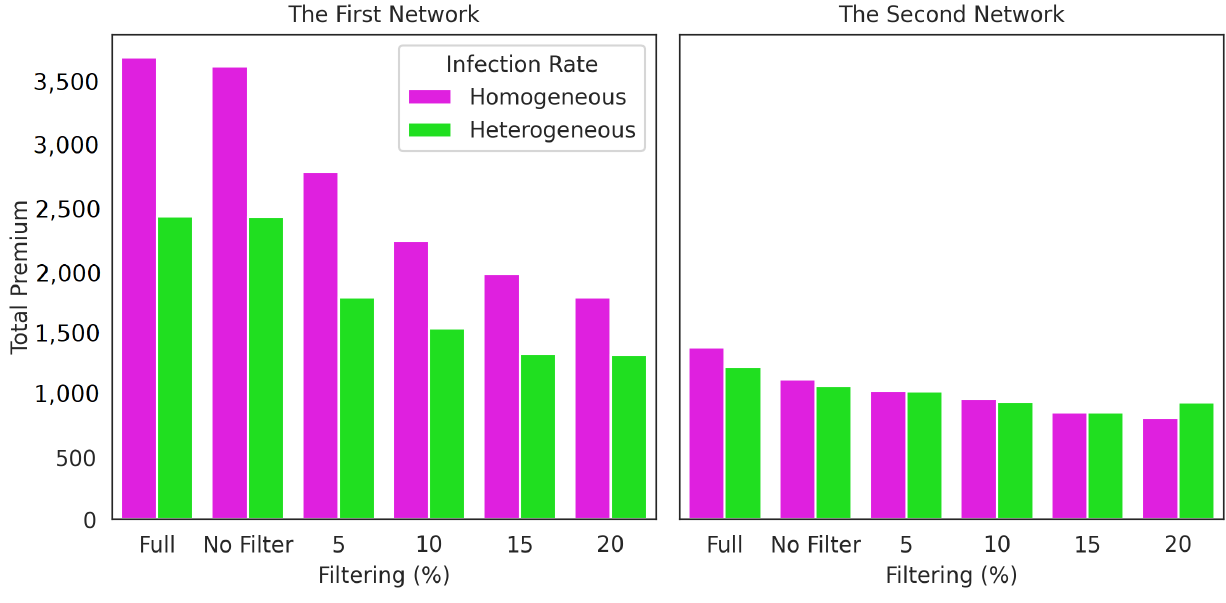
Figure 15. Comparison of homogeneous total premium and heterogeneous total premium in the first and second network for two cases: (1) without GMA (Full) and (2) with GMA (using filter 0% (No Filter), 5%, 10%, 15% and